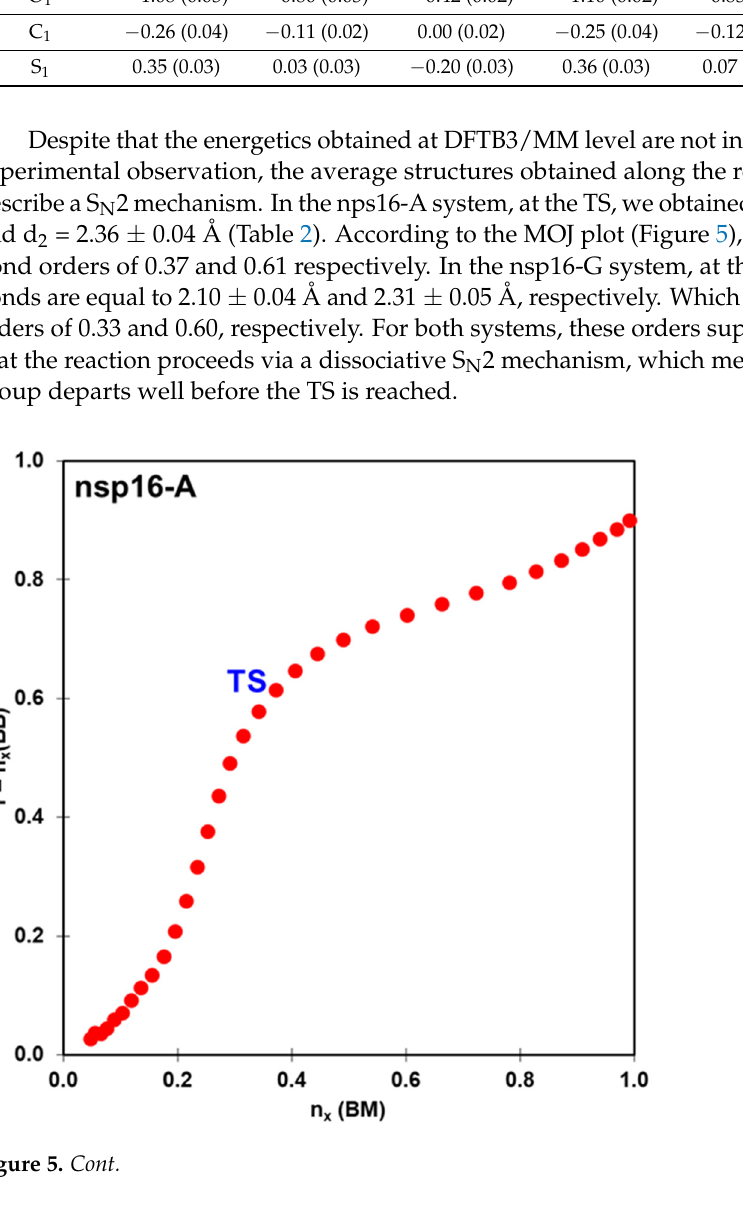
Figure 5. Evolution of O1–C1 bond order, n x , for the S N 2 mechanism of the nsp16-A ( top ) and nsp16-G ( bottom ) systems. 2.3. Interaction Energy Decomposition Analysis The seminal hypothesis of Pauling states that the large rate accelerations for enzymes are due to the high specificity of the protein catalyst for binding the reaction transition state (TS) [35,36]. In principle, the explanation of the catalytic power of enzymes can be achieved by computer-aided methods [37]. This observation allows one to design inhibi-